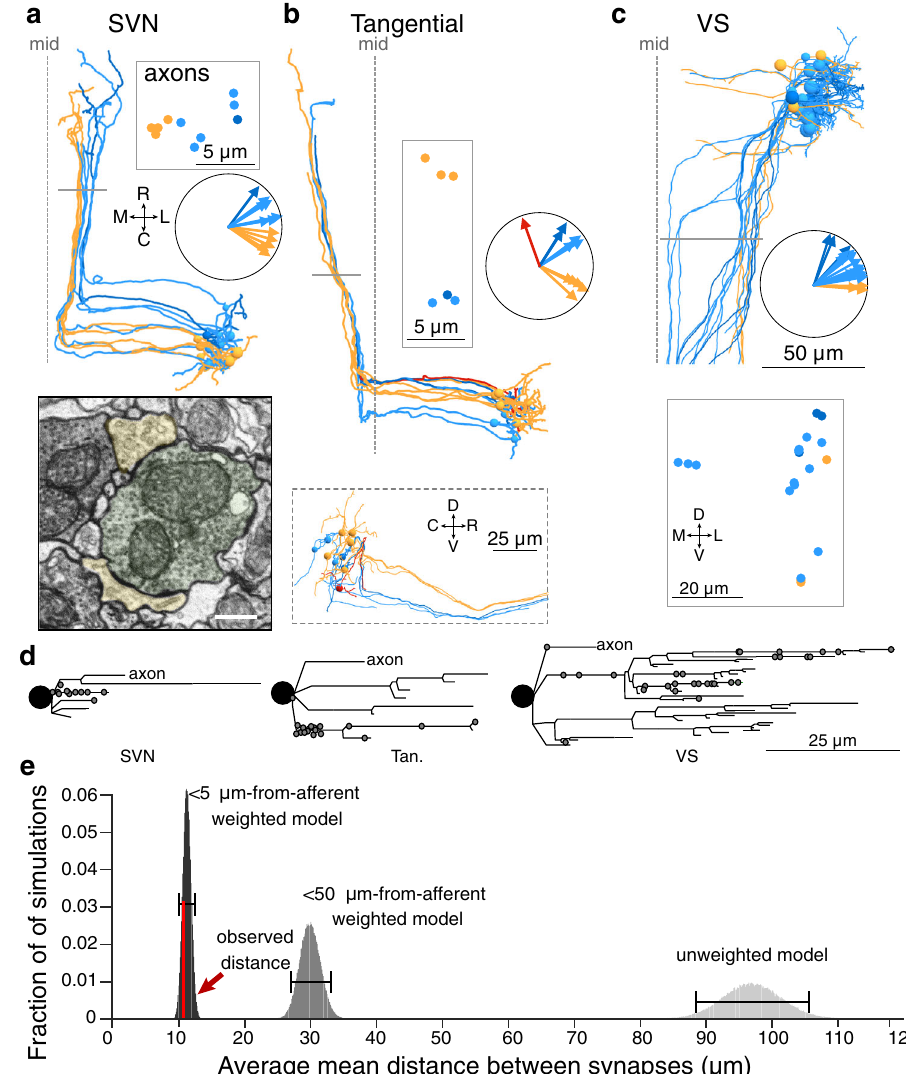
Fig. 4 | Structure and tuning of central VOR and VS utricular targets. a Horizontal projection of 12 SVN reconstructed neurons. Neurons are colorized based on their inferred directional tuning. Polar plot inset shows the directional tuning vectors of each neuron. Gray bar indicates location of coronal plane where axon trajectories are shown in boxed inset. Scale for reconstructions as in c . Elec- tron micrograph (bottom) shows a utricular afferent (pseudocolored green) con- tacting two dendrites of SVN neurons (yellow). Scale bar, 500nm. b As in a , for 11 tangentialnucleusreconstructedneurons.Sagittalprojectioninset(bottom)shows thedivergenceoftangentialneuronaxonsinthedorsoventralaxis. c Asin a butfor 19VSneurons. d DendrogramsofthreeexampleneuronsfromtheSVN,tangential,